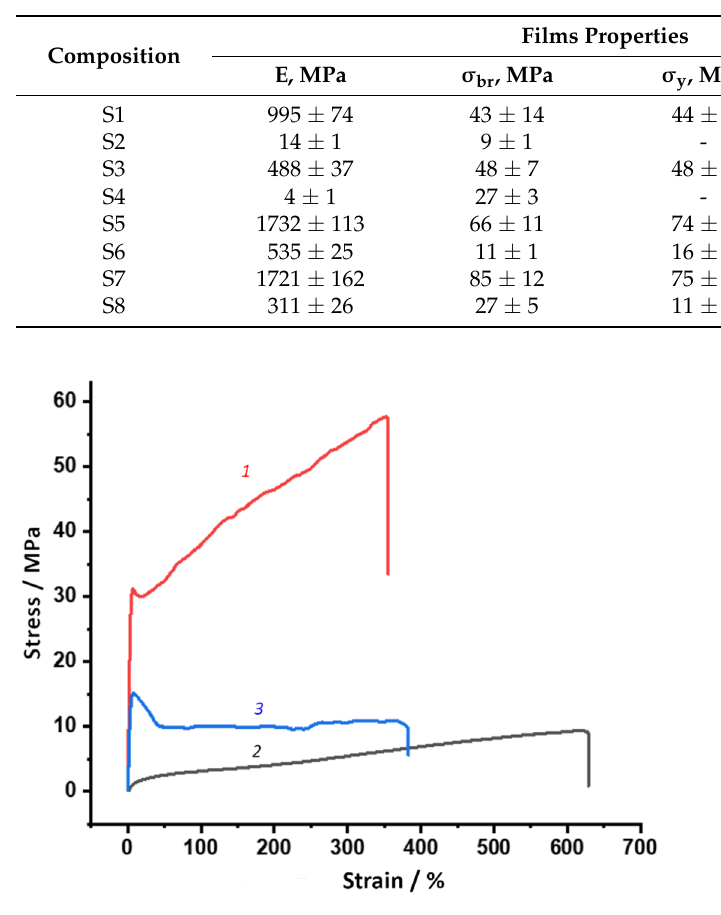
Figure 13. Strain ‐ stress curves for S1 ( 1 ), S2 ( 2 ), and S6 ( 3